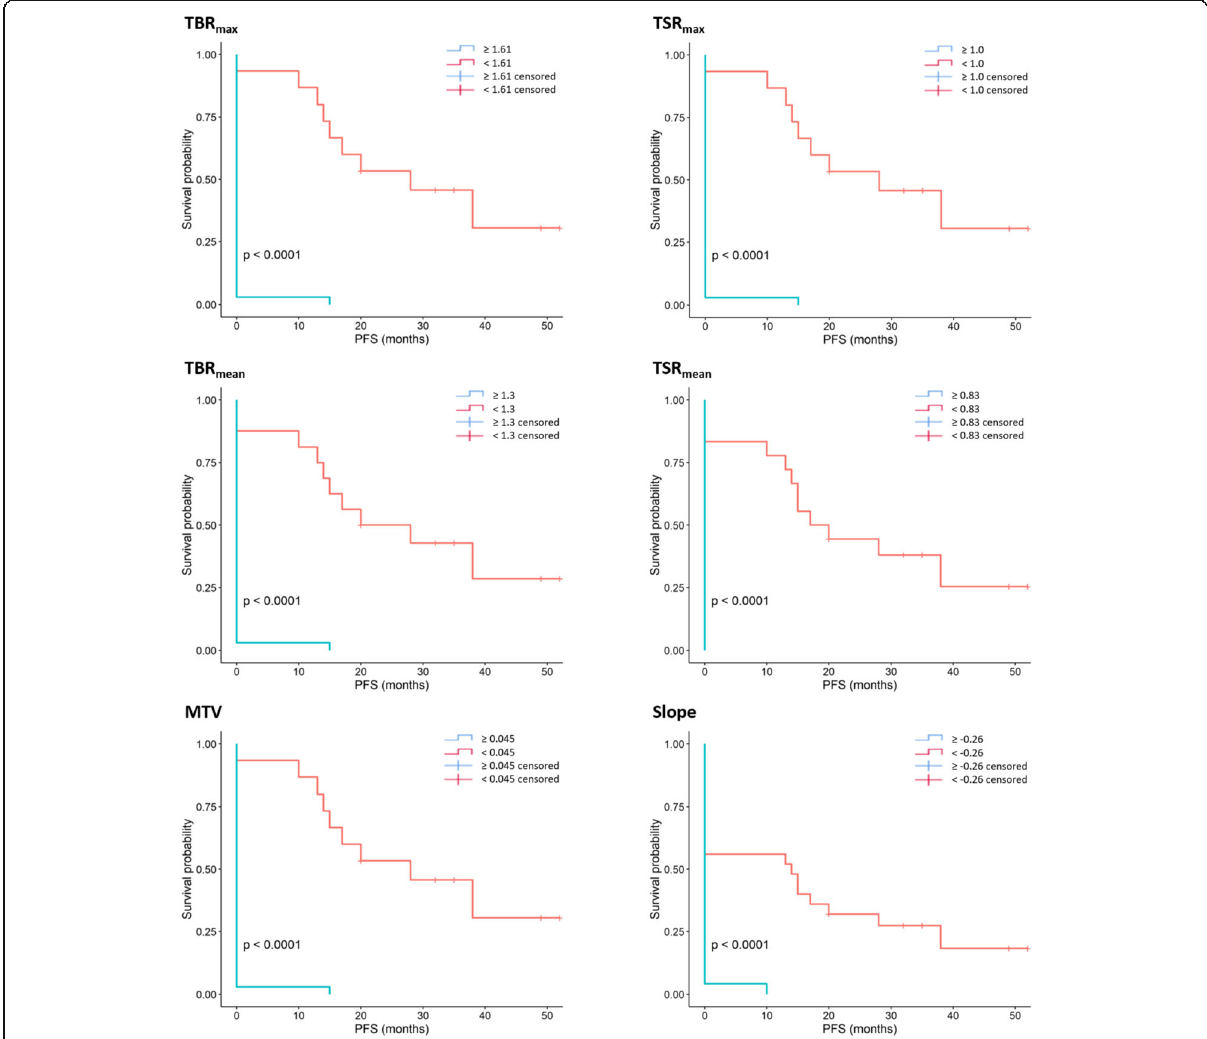
Fig. 2 Kaplan-Meier survival plots for the prediction of progression-free survival using maximal tumor-to-background ratios (upper left panel), mean tumor-to-background ratios (middle left panel), metabolic tumor volume (lower left panel), maximal tumor-to-striatum ratio (upper right panel), mean tumor-to-striatum ratio (middle right panel), and slope (lower right panel) as discriminators. Corresponding log-rank test adjusted p values are < 0.0001 for all presented